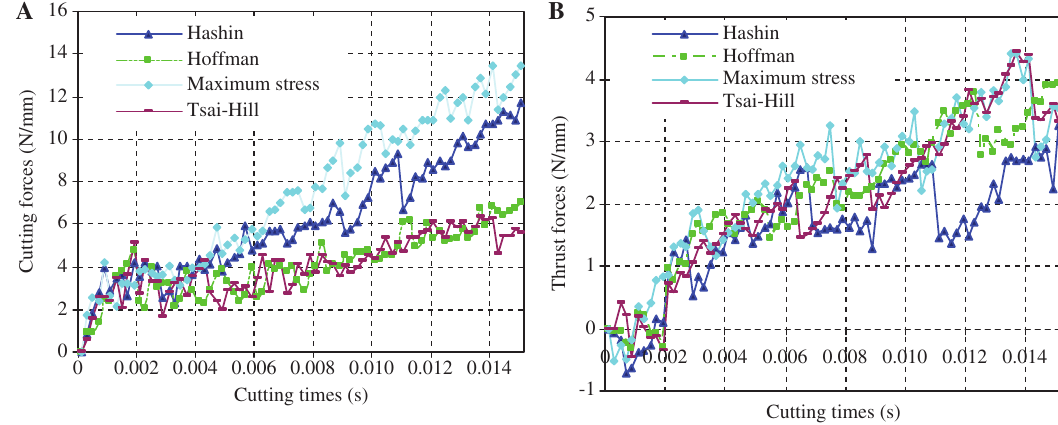
Figure 2: Cutting and thrust forces for instantaneous failure with 1% residual stiffness (& = 0.01, fiber orientation 45 °